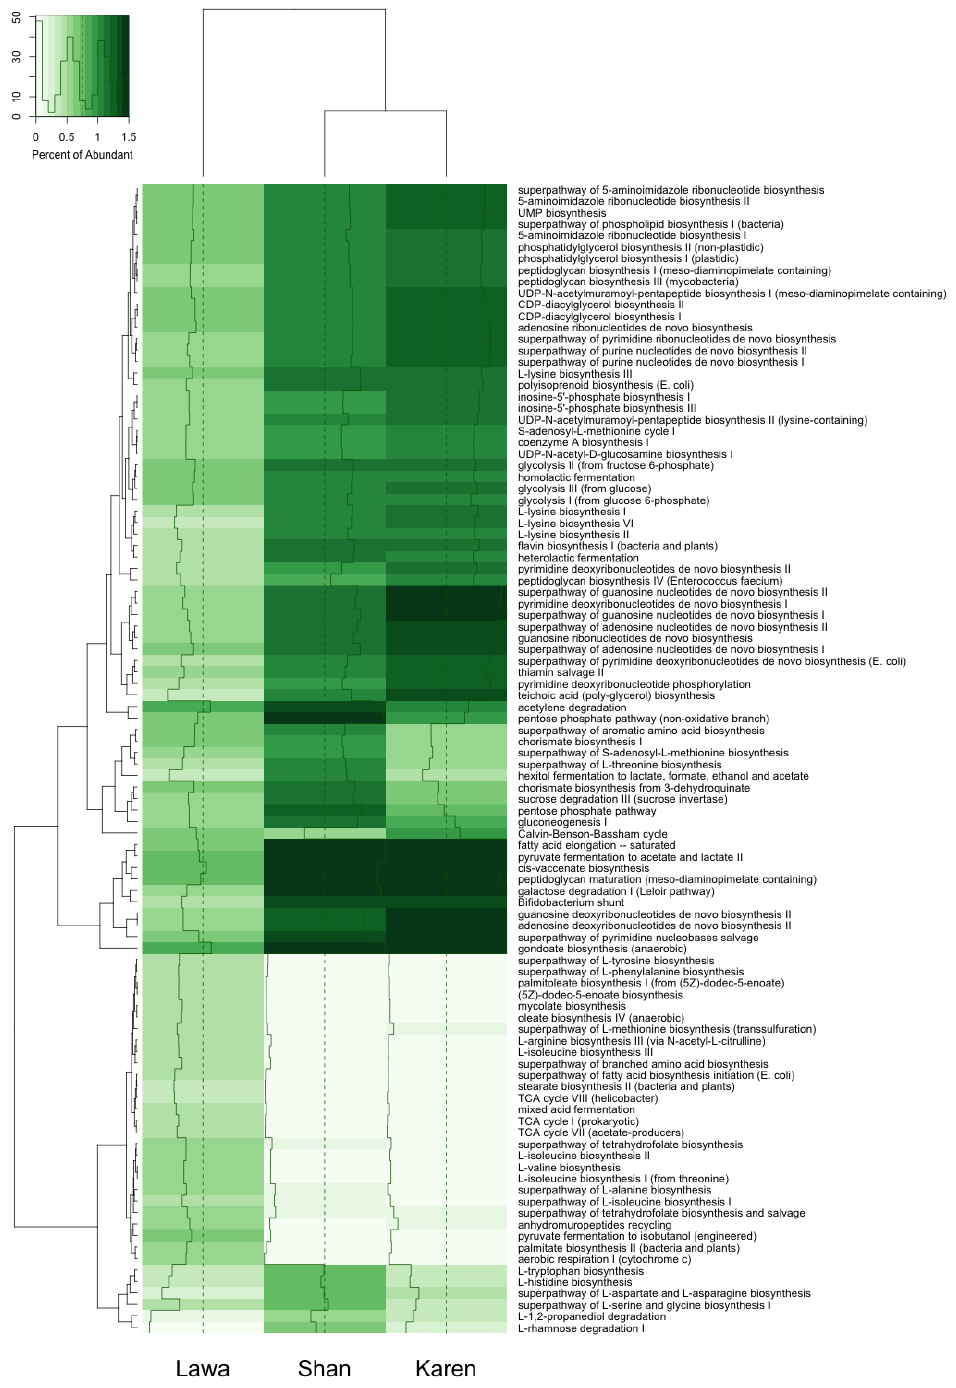
Figure 4. The functional genes heatmap of bacterial communities in the PGDs of the Karen, Lawa, and Shan. The predicted functional genes of the Shan and Karen PGDs and their abundance percentages were similar, while those of the Lawa PGD were different.